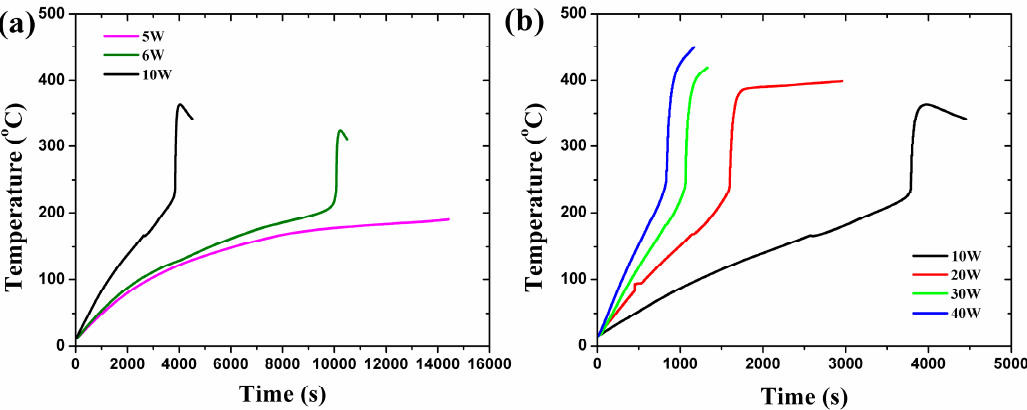
Figure 2. Temperature curves at different constant heating powers. ( a ) Low heating power; ( b ) High heating power. Table 2. Measured values during experiments in scenario 1.